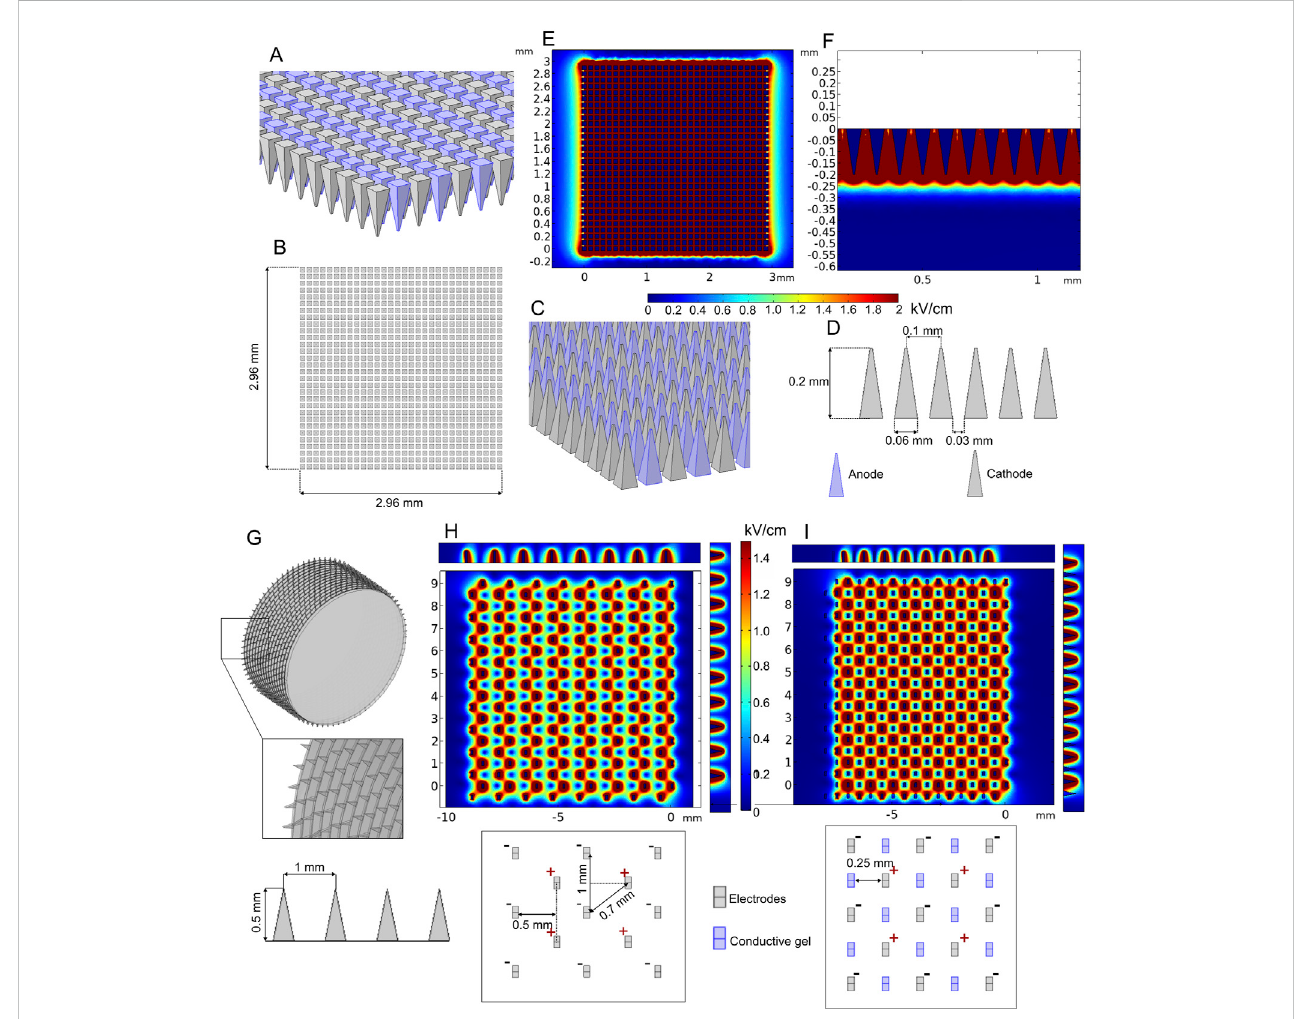
Microneedle array (A – F) and multi-needleroller (G – I) electrodes when 100 V voltage isapplied: (A – D) microneedle arraymodel; (E) spatial electric fi eld distribution,topview; (F) spatialelectric fi elddistribution,sideview; (G) multi-needlerollermodel; (H) spatial electric fi elddistributionwithoutconductivegel; (I) spatial electric fi eld distribution with conductive gel